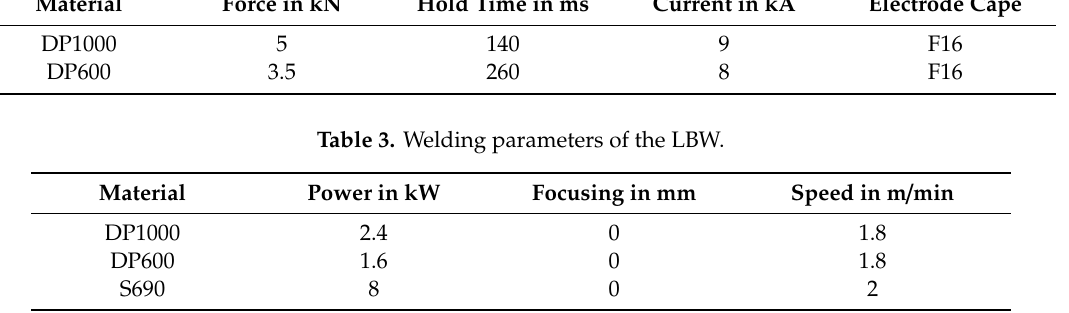
Table 3. Welding parameters of the LBW.